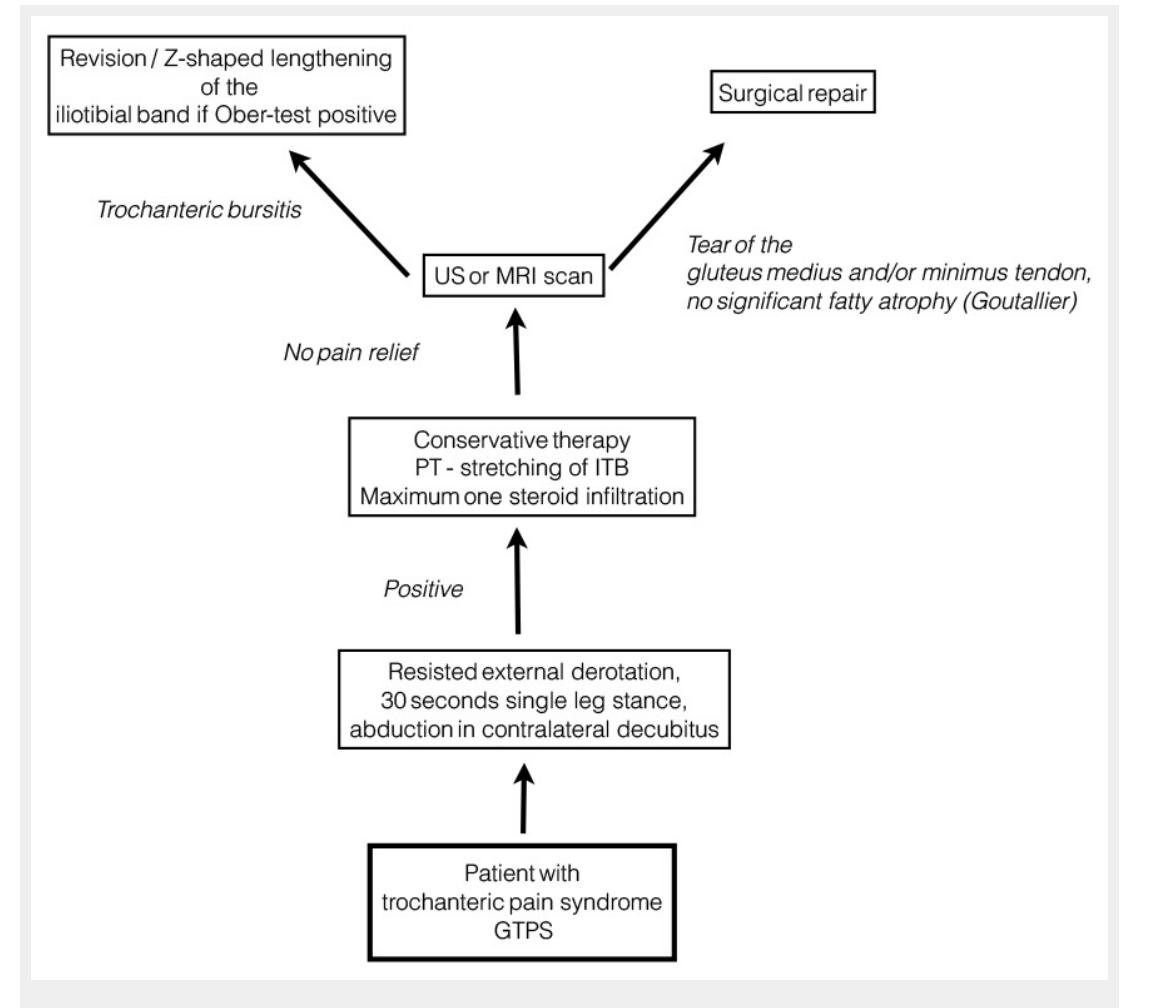
Figure 2 Diagnostic algorithm for greater trochanteric pain after total hip replacement [58, 95]. ITB = iliotibial band; MRI = magnetic resonance imaging; PT =